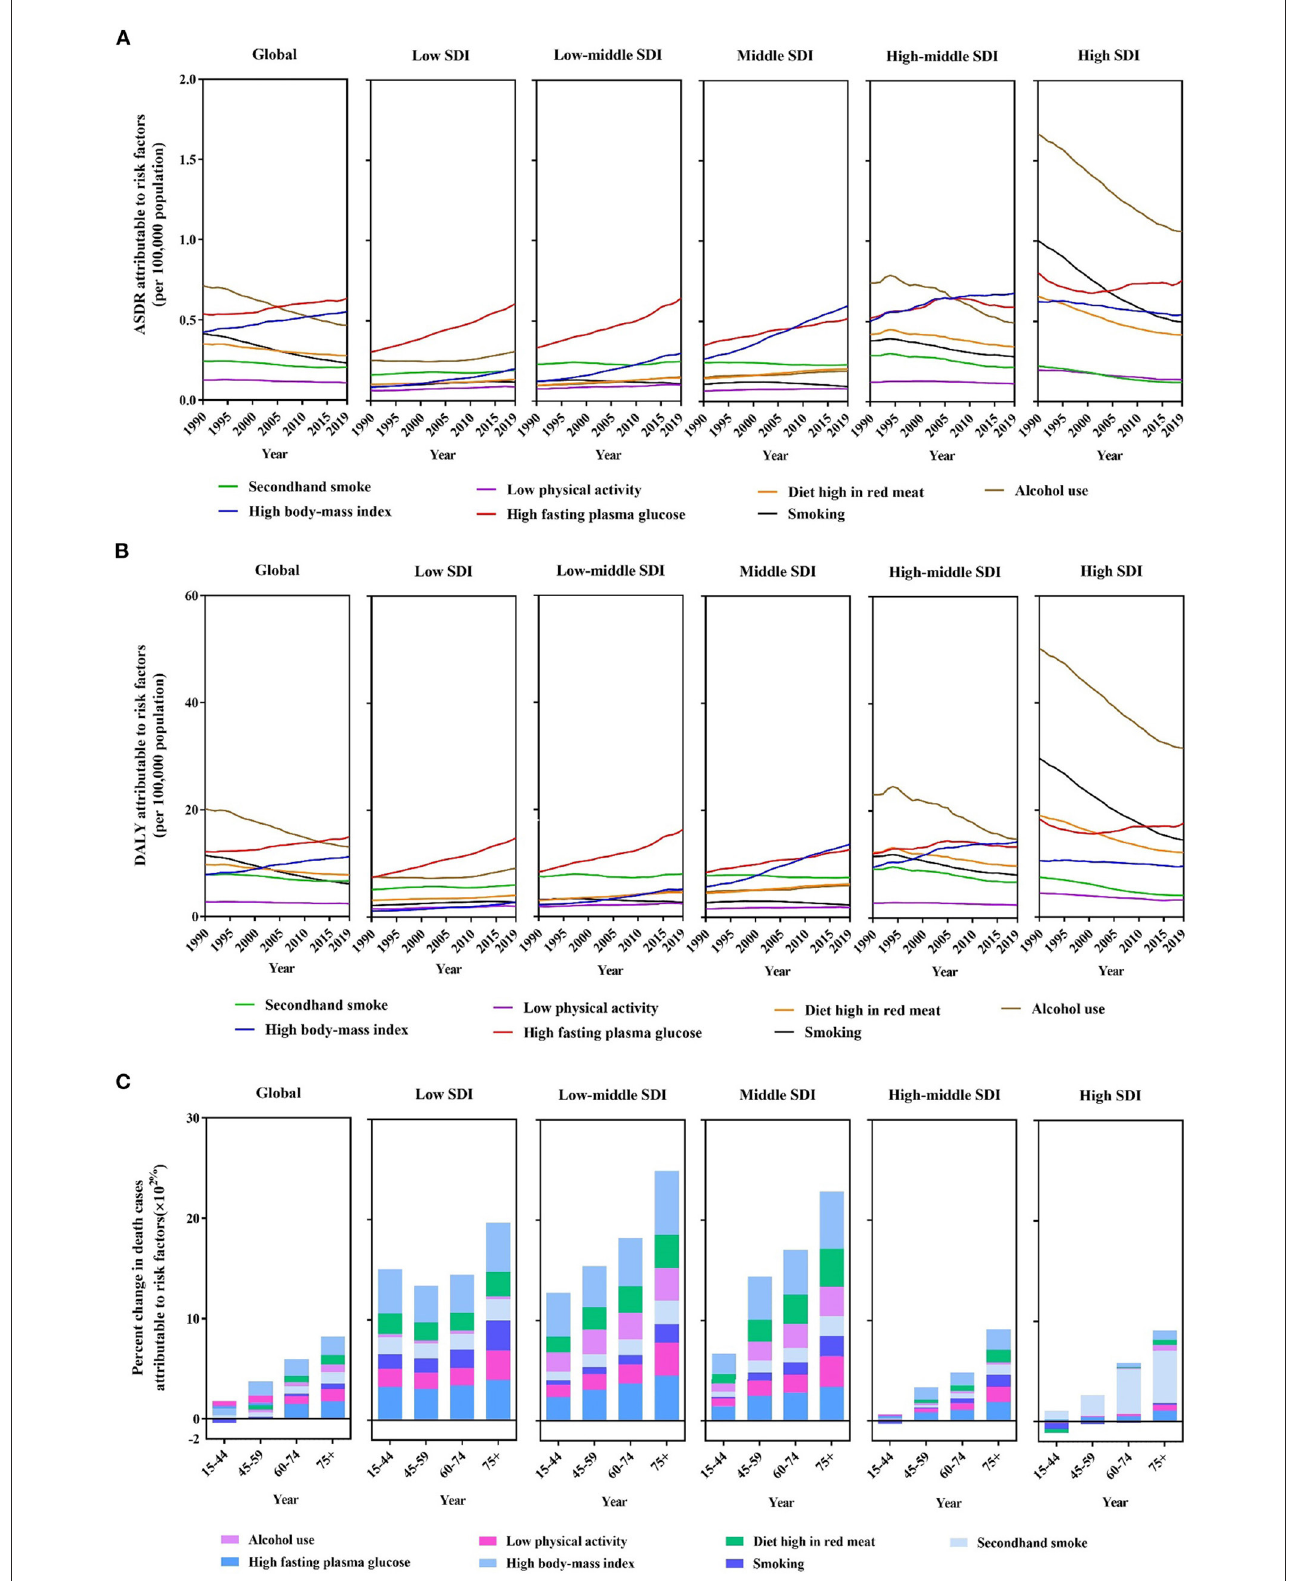
FIGURE3 A predominant contribution of risk factors to breast cancer-related deaths by SDI regions and age groups. (A) ASDRs attributable to main risk factors by SDI regions from 1990 to 2019. (B) Disability-adjusted life years (DALYs) attributable to main risk factors by SDI regions from 1990 to 2019. (C) Percentage changes in deaths attributable to four metabolic risk factors by age groups and SDI regions between 1990 and